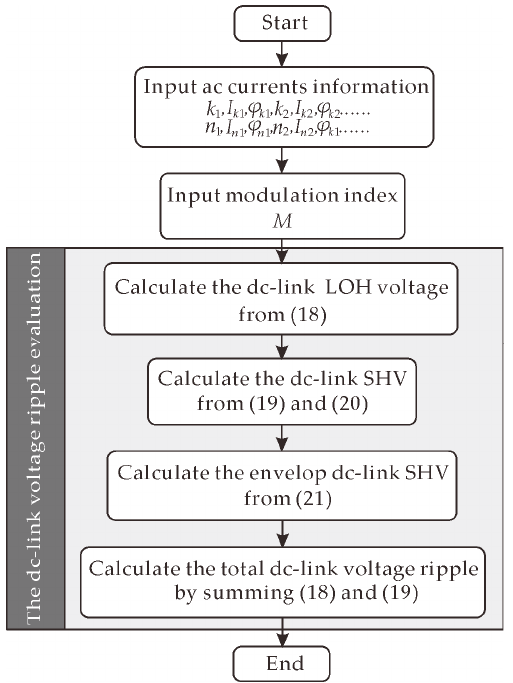
Figure 4. The flow chart of the dc-link voltage ripple with nonlinear output current.